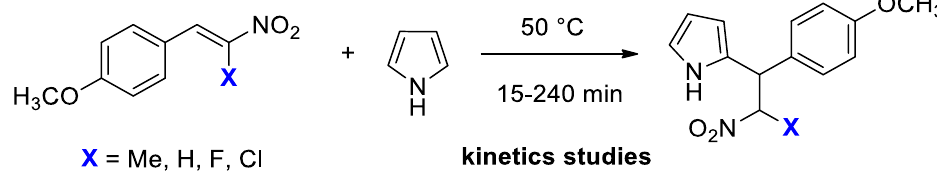
Scheme 3. Kinetics studies of the substituent effect at the double bond.